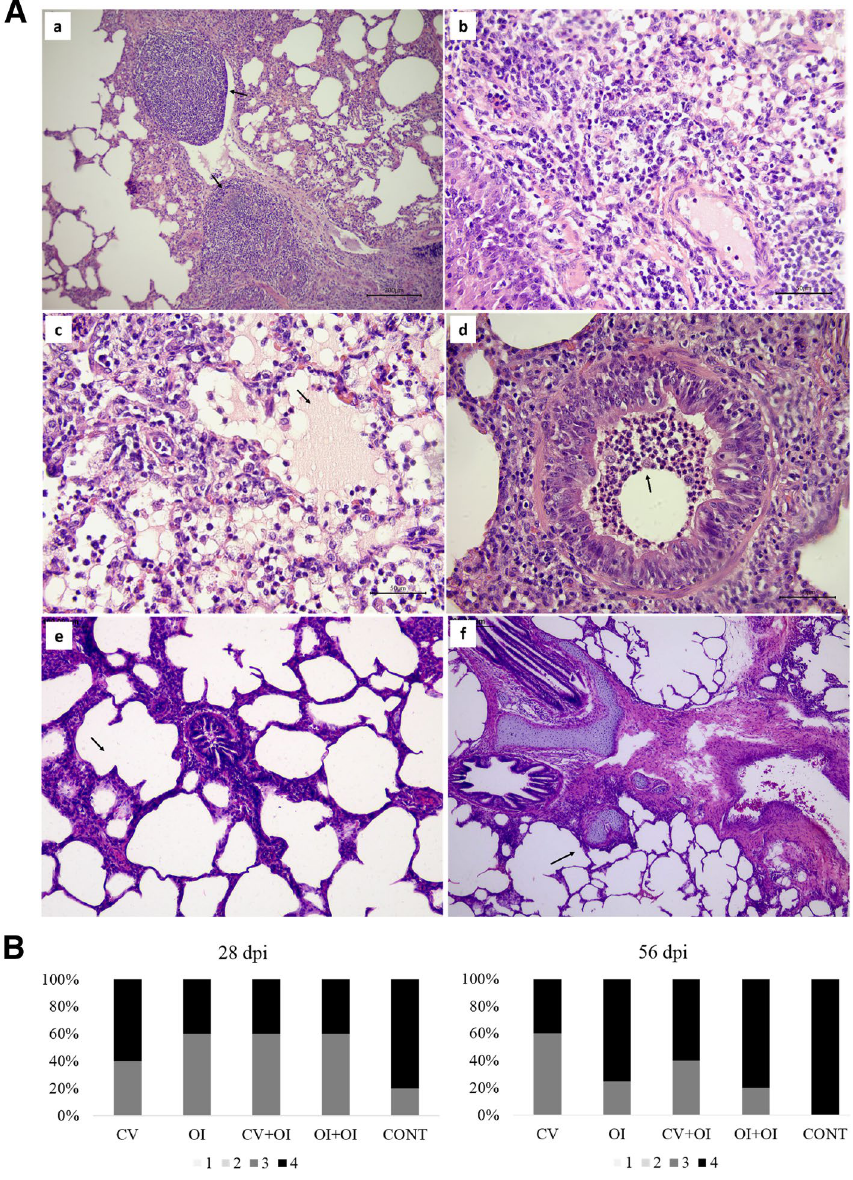
Figure 2. ( A ) Photomicrography of histological lung lesion characterized by (a) hyperplasia of lymphoid follicles (arrow) (100 ×); (b) inflammatory infiltrate predominantly compound by macrophages (400 ×); (c) amorphous and acidophilic material in addition to inflammatory infiltrate in the light of the alveoli (arrow) (100 ×); (d) inflammatory infiltrate in bronchioles (arrow) (400 ×); (e) light of the alveoli without noteworthy changes (arrow) (100 ×); (f) normal lymphoid follicle (arrow) (40 ×). ( B ) Percentage of animals showing different microscopic lung lesion score (0–4) according to each vaccination protocol. No significant differences were observed between